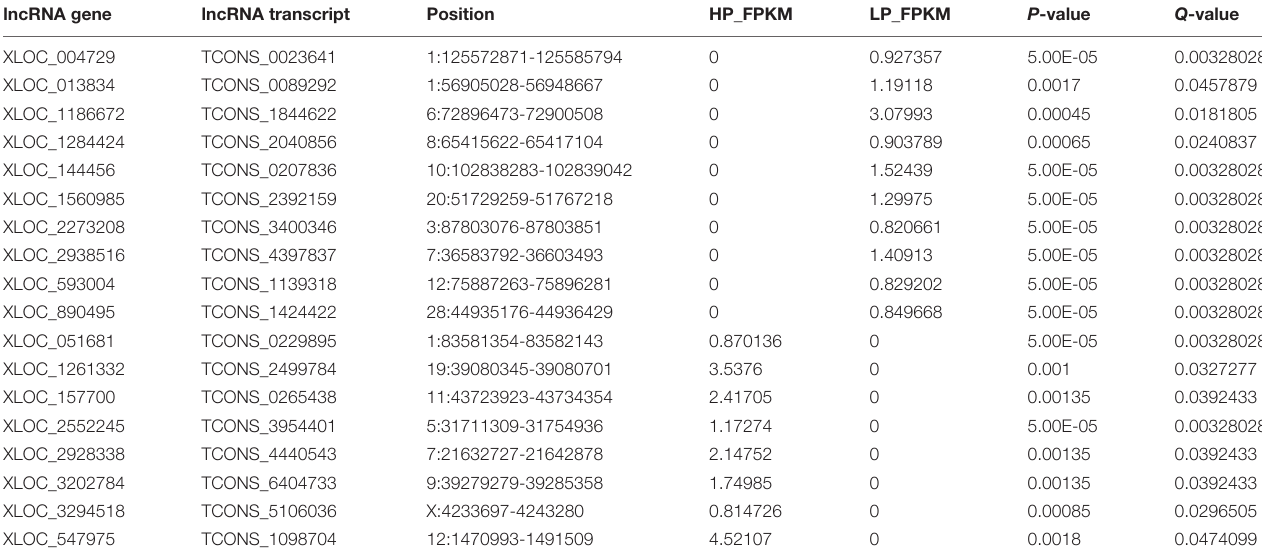
TABLE 1 | The differential lncRNAs specifically expressed in HP group or LP group.